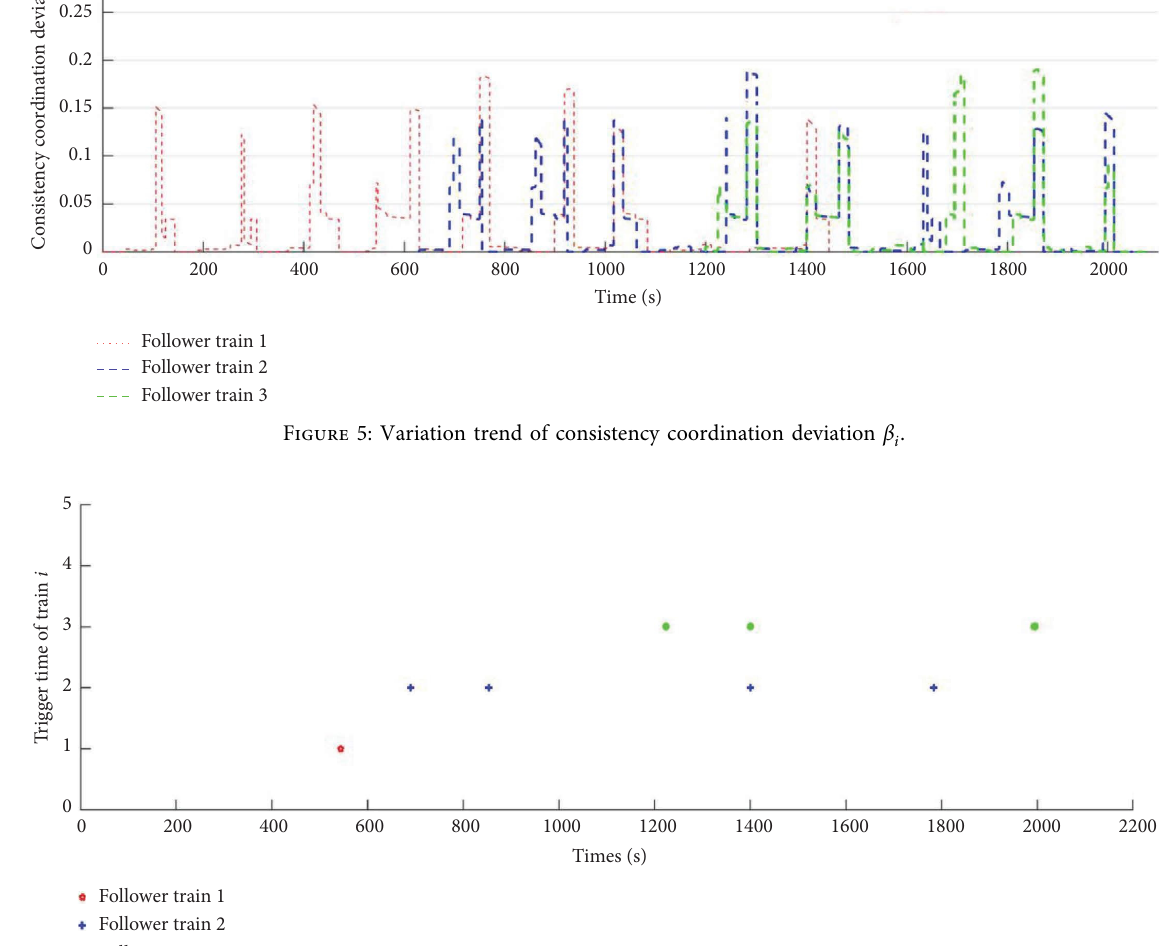
Figure 6: Train trigger time.